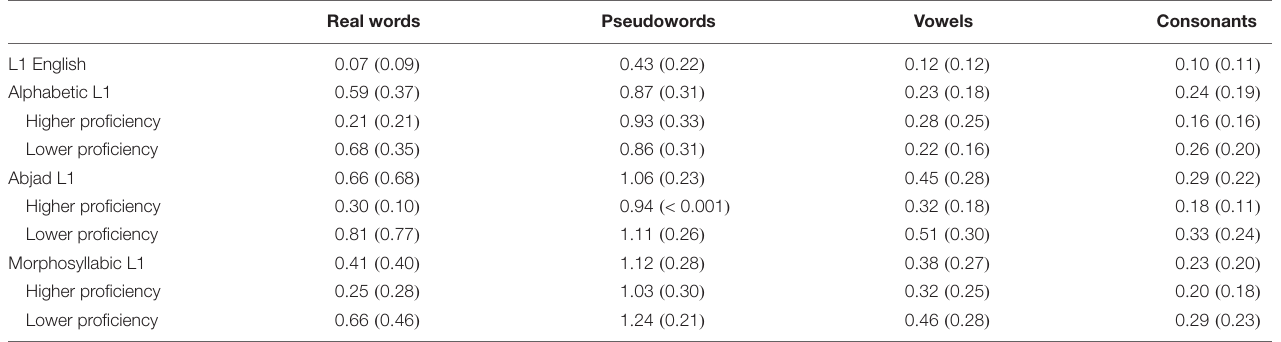
TABLE 6 | Error analyses - mean error rates (per item) to different item types (real words, pseudowords) and segment types (vowels, consonants) by L1 background and ESL proficiency